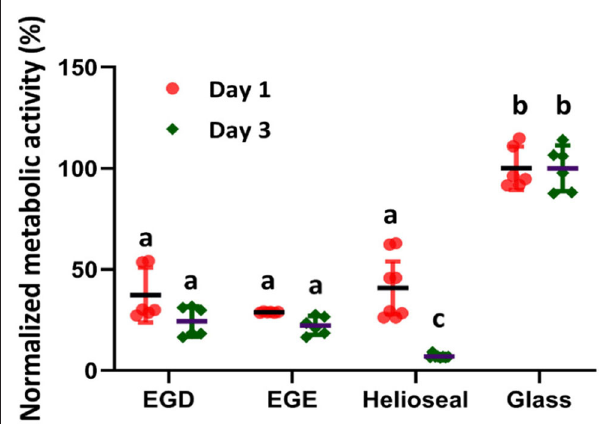
FIGURE 3 | Metabolic activity of oral keratinocyte cells incubated on the EGDMA, EGEMA, HelioSeal (commercially available) discs and glass as control. Graph based on data repository reference